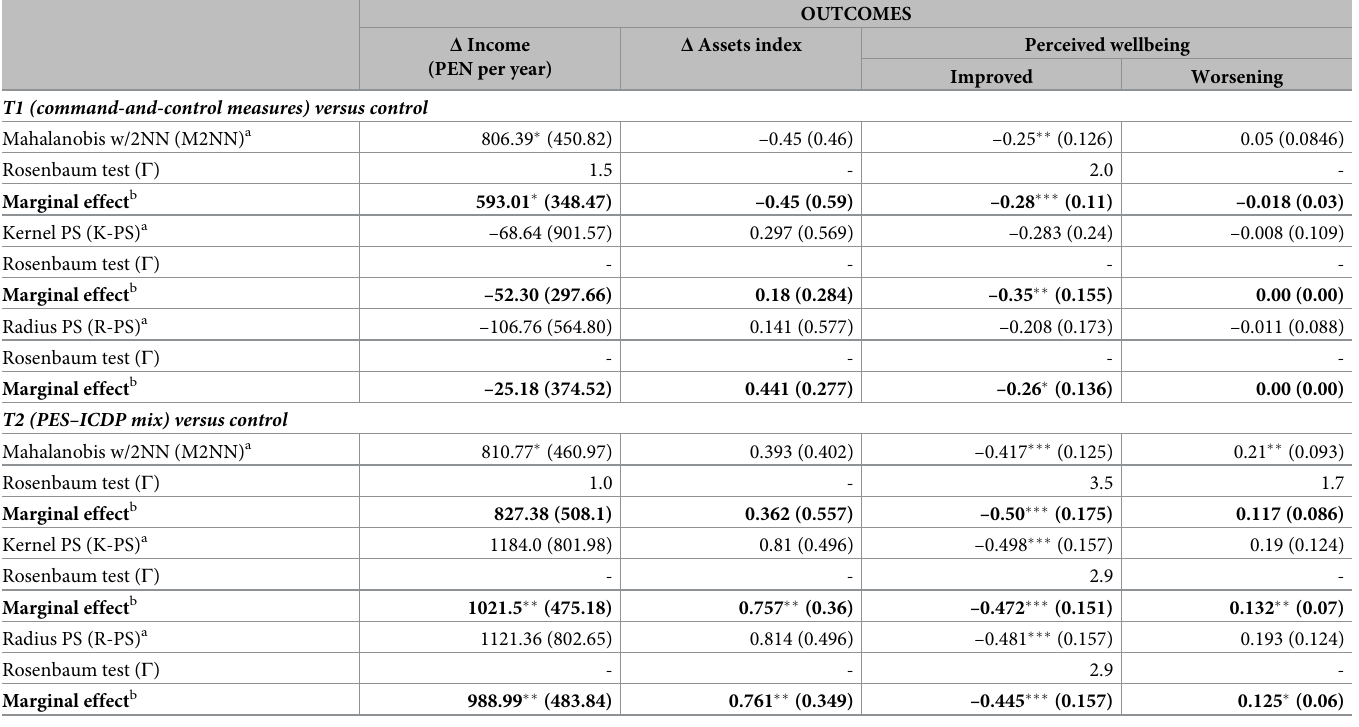
Table 4. The effects of treatments on household